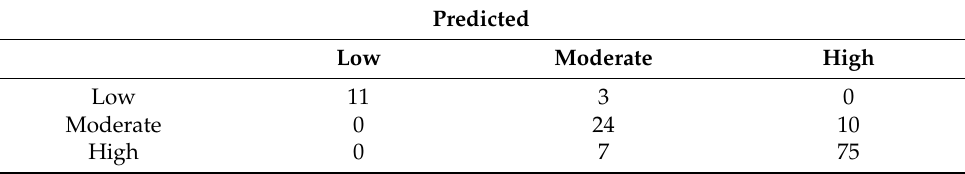
Table A4. Confusion matrix for the predicted vs. real values in the testing set.